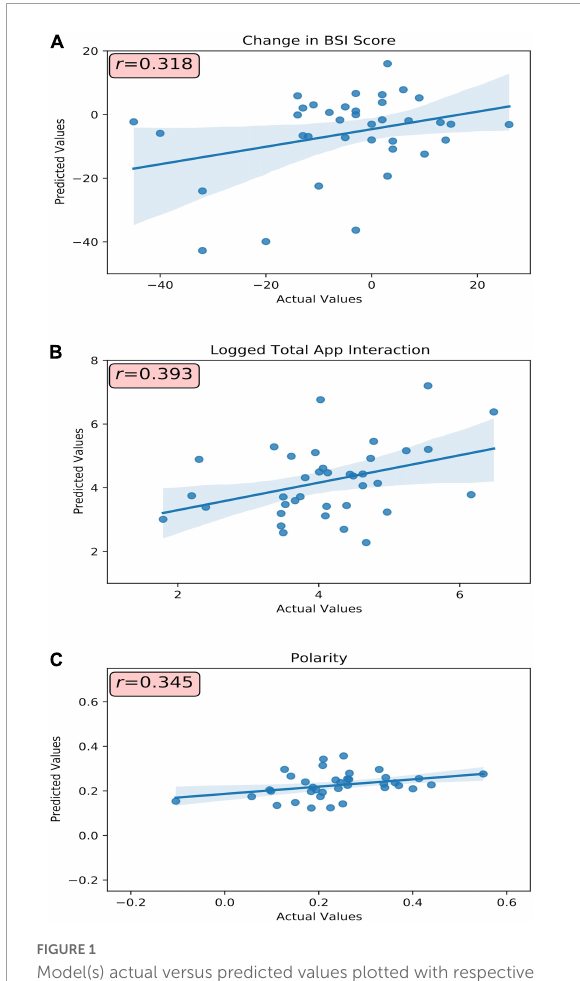
FIGURE1 Model(s) actual versus predicted values plotted with respective correlative strength. (A) Baseline BSI total score, subcategory scores, and passively collected A4i use metrics were used to predict change in BSI total score. (B) Baseline BSI total score and subcategory scores were used to predict a participants’ overall interaction (visualized as the log-transformation) with the A4i app. (C) Baseline BSI total score and subdomain scores were used to predict an individual participant’s sentiment toward the intervention. r, Pearson’s correlation